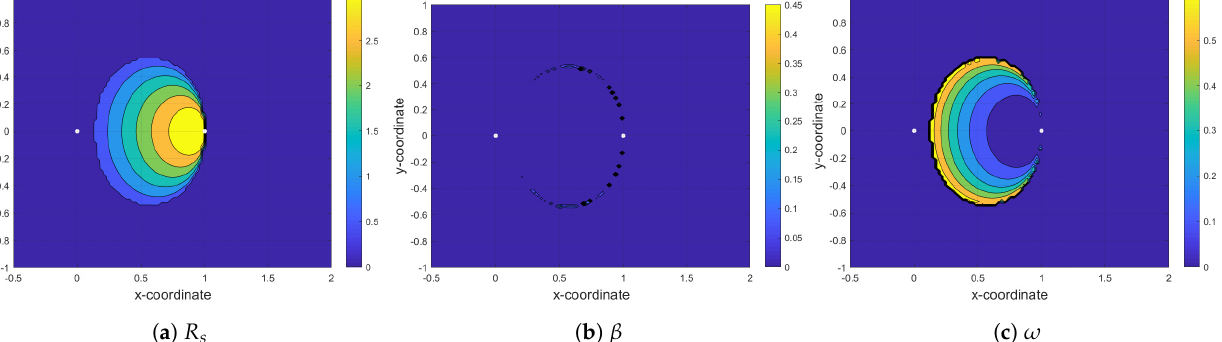
Figure 6. Maximizing rate at the second receiver (SR) by finding the optimum value for time fraction ( β ) and power fraction ( ω ) in the AF-NOMA protocol.